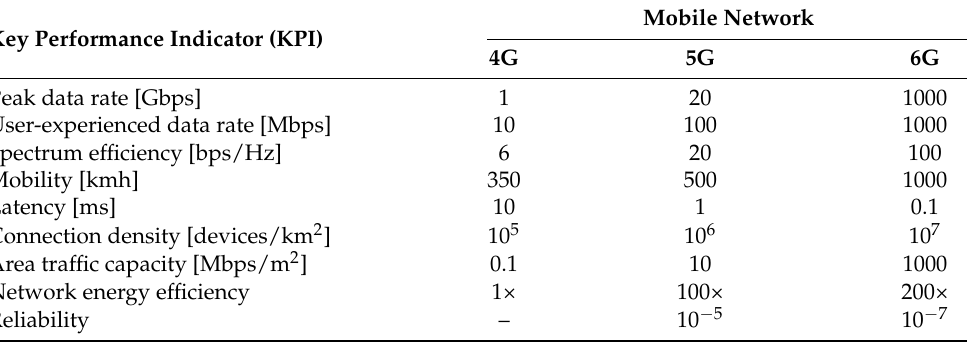
Table 3. Comparison of performance peaks offered by 4–6G mobile networks (based on [90,138–140]). Key Performance Indicator (KPI)